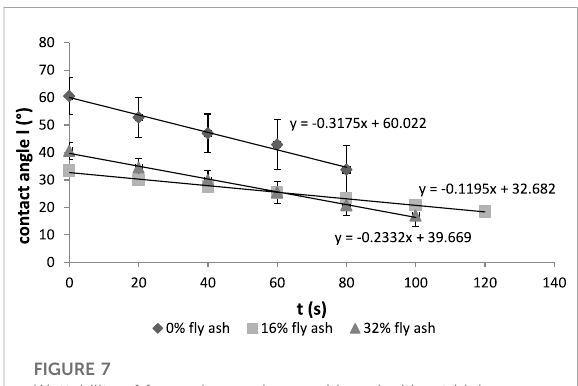
FIGURE 7 Wettability of foamed geopolymer with and without high- carbon fl y ash (sodium-based geopolymer).